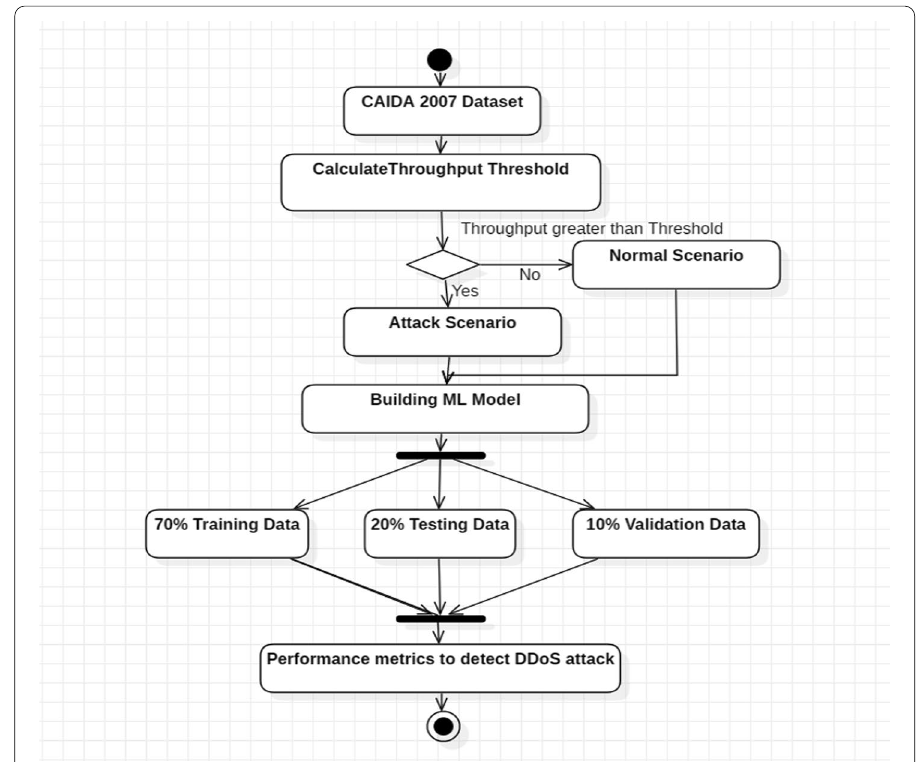
Fig. 2 Activity Diagram for experimental